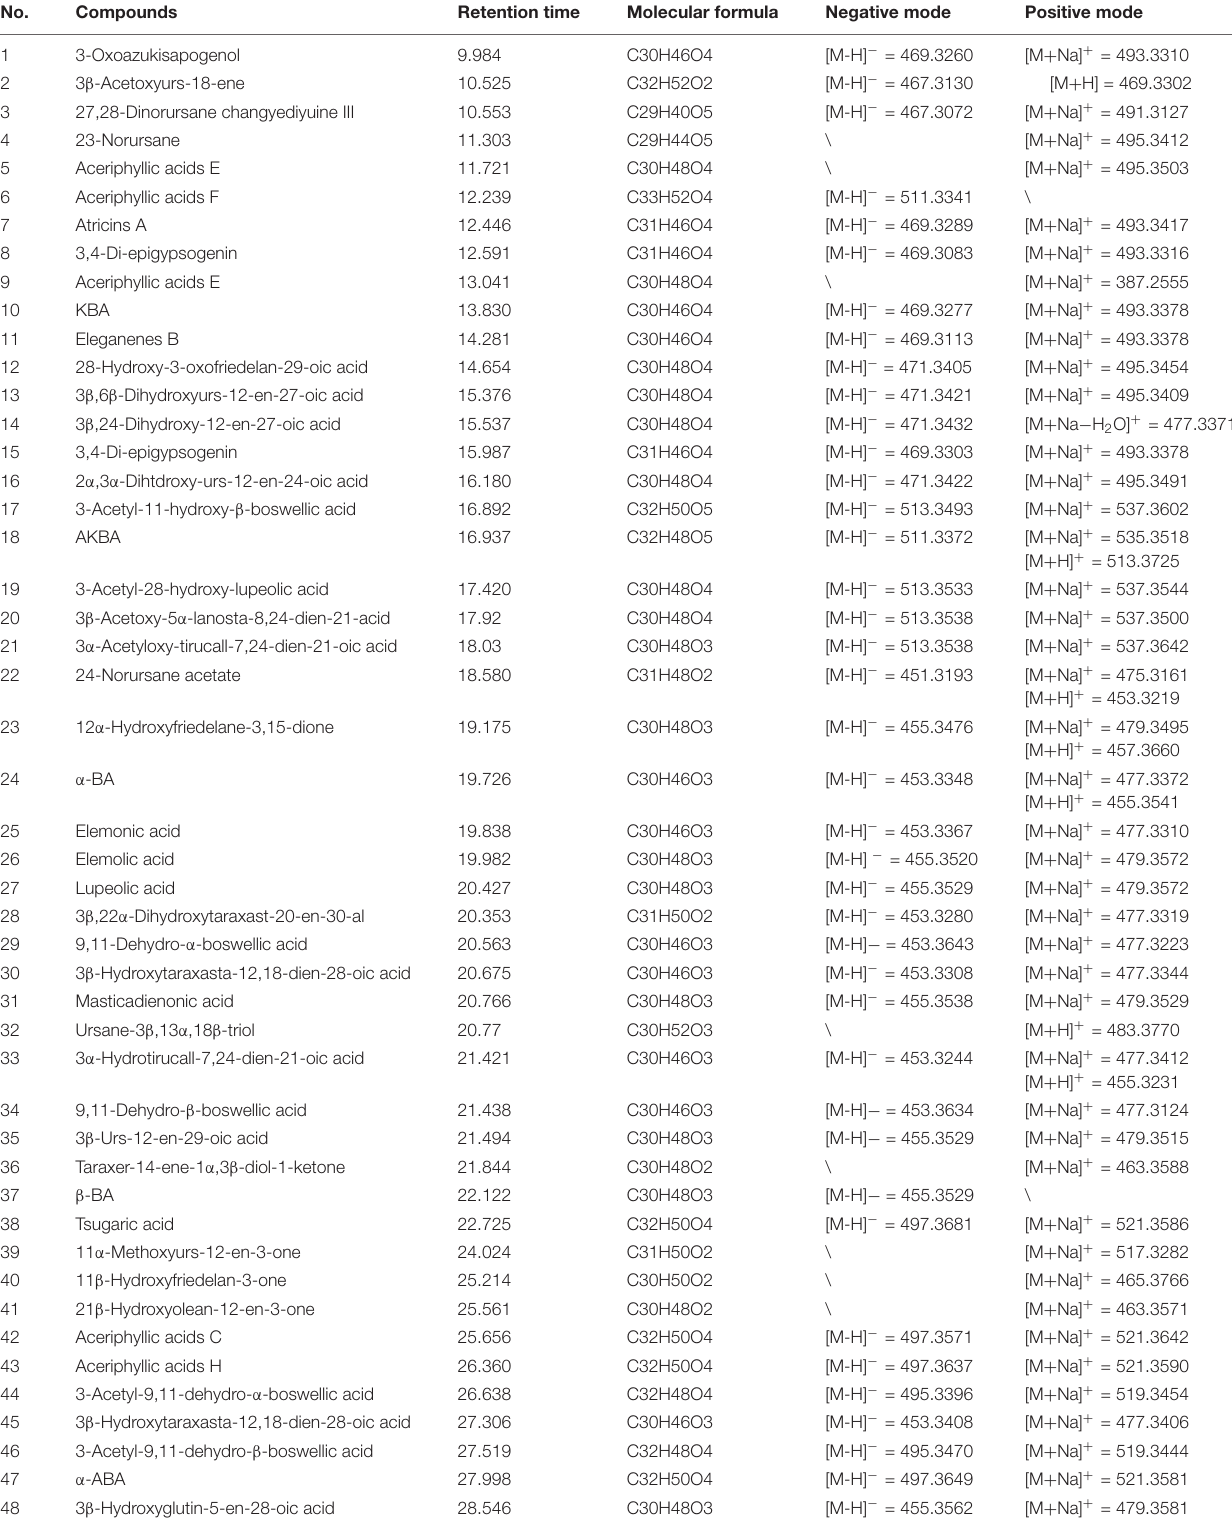
TABLE 1 | Components identified in frankincense and processed